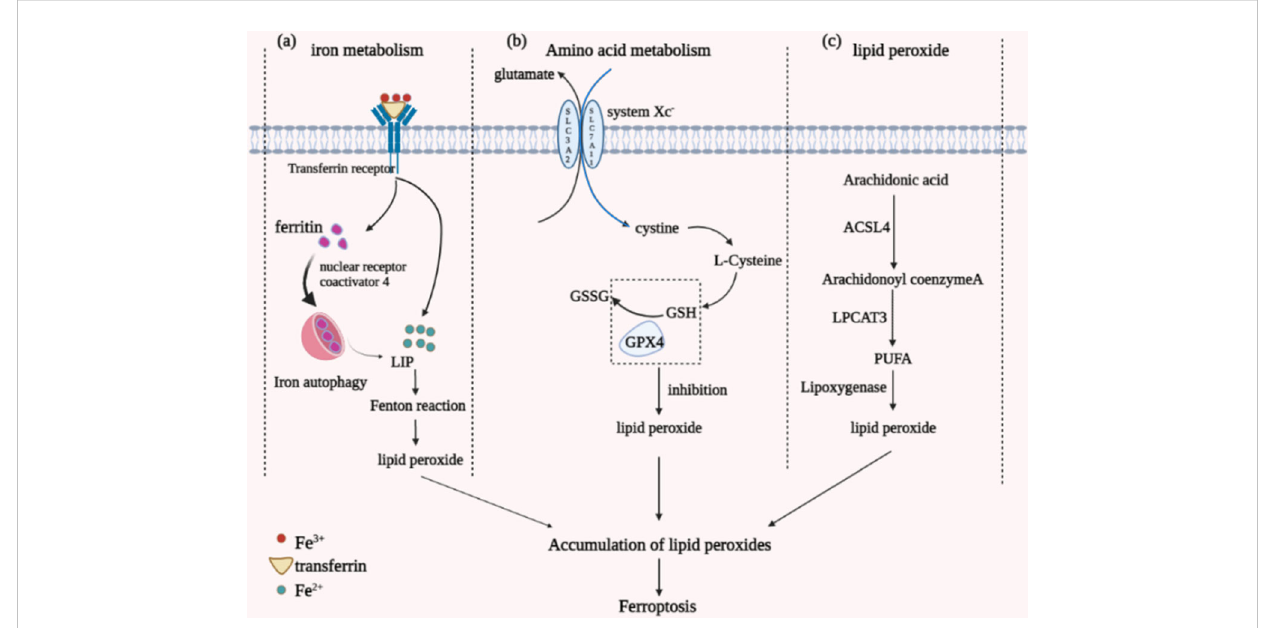
FIGURE 1 Diagram of the different mechanisms by which ferroptosis occurs. (A) iron metabolism; (B) amino acid metabolism; (C) lipid peroxide